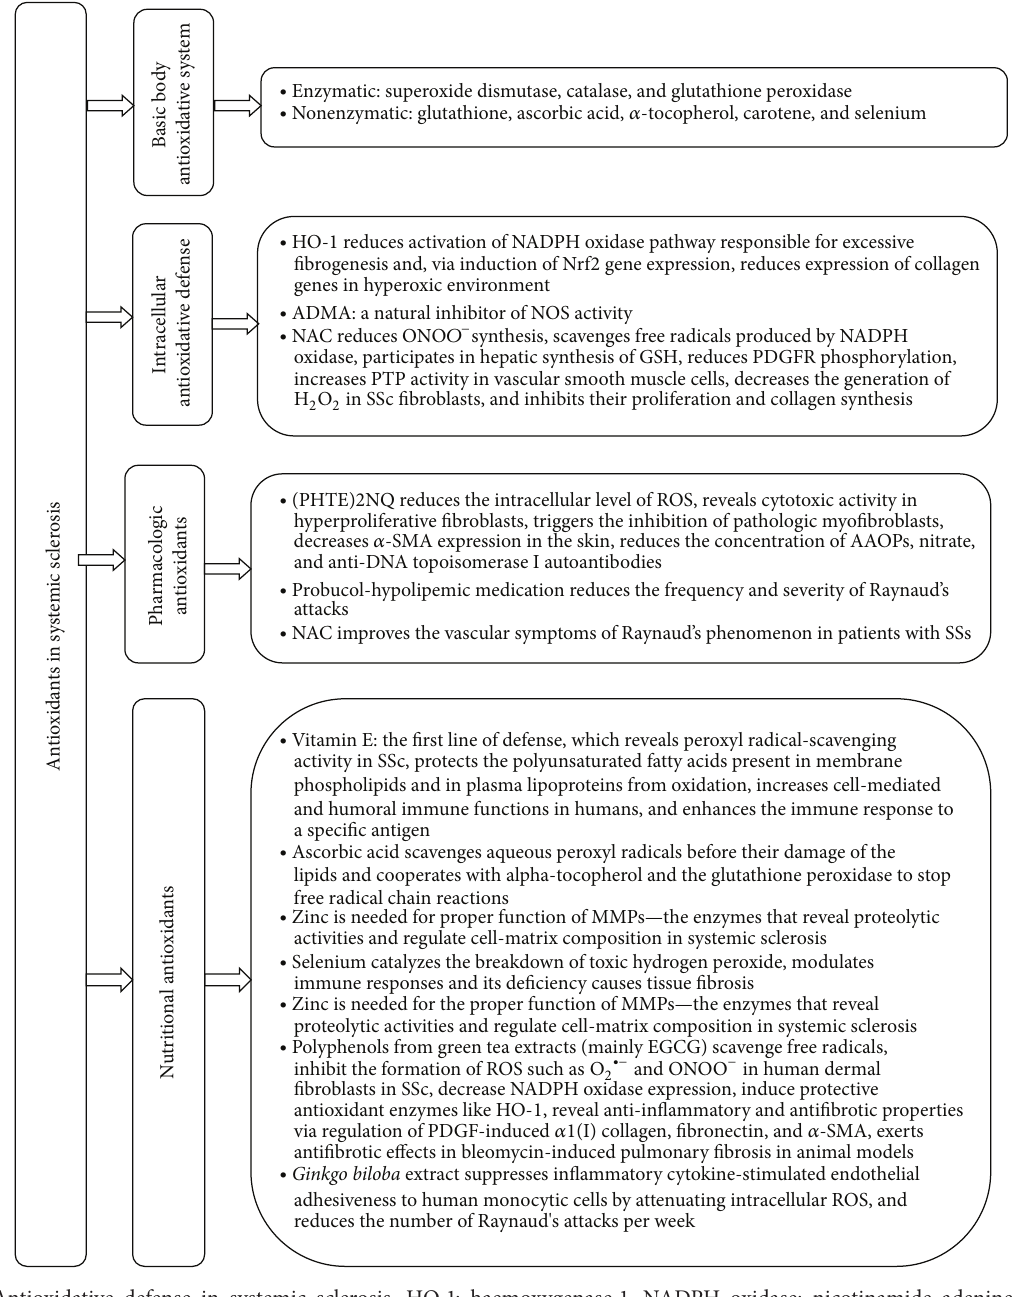
Figure 4: Antioxidative defense in systemic sclerosis. HO-1: haemoxygenase-1, NADPH oxidase: nicotinamide adenine dinucleotide phosphate-oxidase,Nrf2:nuclearfactorerythroid-2-relatedfactor2,ADMA:asymmetricdimethylarginine,NOS:nitricoxidesynthase,NAC: N-acetyl-l-cysteine, ONOO − : peroxynitrite, GSH: glutathione, PDGFR: antiplatelet derived growth factor receptor, PTP: protein tyrosine phosphatases, H 2 O 2 : hydrogen peroxide, (PHTE)2NQ: 2,3-bis(phenyltellanyl)-naphthoquinone, ROS: reactive oxygen species, 𝛼 -SMA: alpha-smooth muscle actin, AOPPs: advance oxidation protein products, MMPs: matrix metalloproteinase-1, EGCG: ( − )-epigallocatechin- 3-gallate, O 2∙− : superoxide anions, and PDGF: antiplatelet derived growth